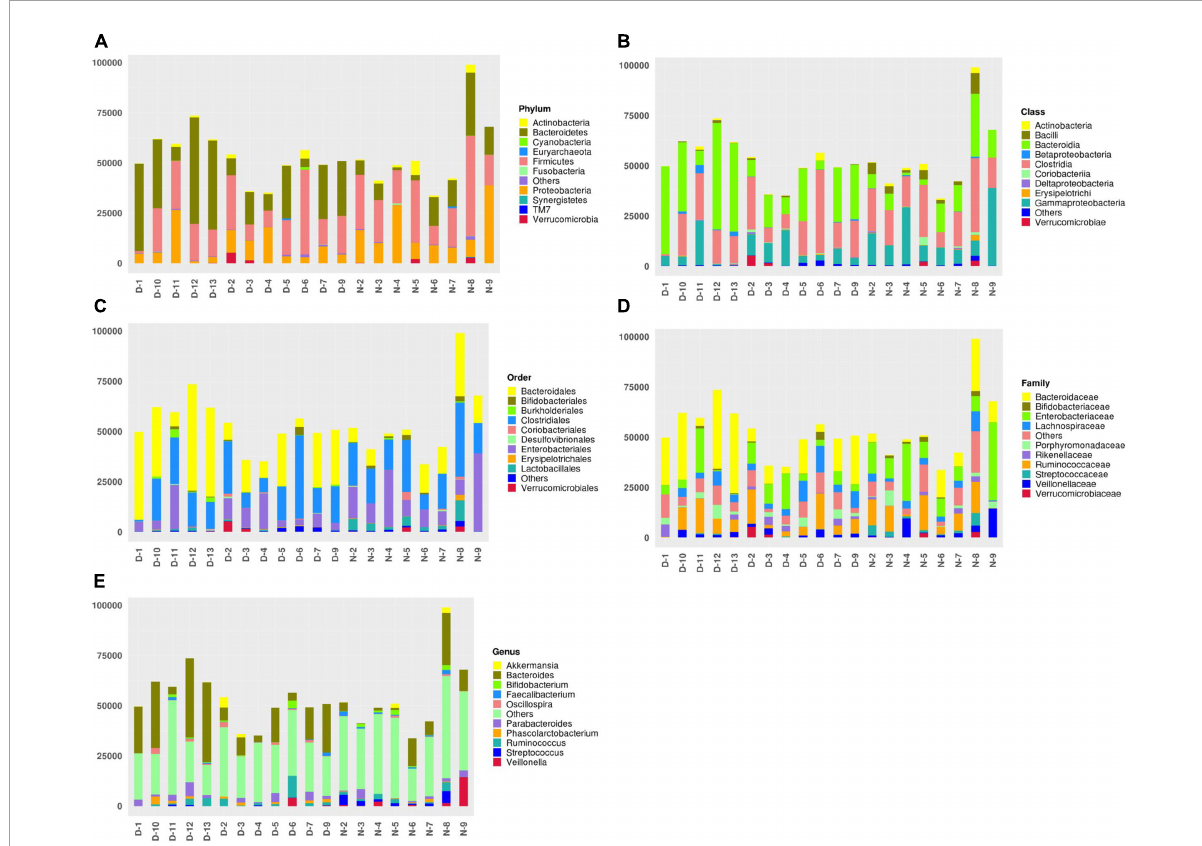
FIGURE1 (A) The top 10 bacteria at the phylum level: Actinobacteria, Bacteroidetes, Cyanobacteria, Euryarchaeota, Firmicutes, Fusobacteria, Others, Proteobacteria, Synergistetes, TM7, and Verrucomicrobia. (B) The top 10 bacteria at the class level: Actinobacteria, Bacilli, Bacteroidia, Betaproteobacteria, Clostridia, Coriobacteriia, Deltaproteobacteria, Erysipelotrichi, Gammaproteobacteria, Others, and Verrucomicrobiae. (C) The top 10 bacteria at order level: Bacteroidales, Bifidobacteriales, Burkholderiales, Clostridiales, Coriobacteriales, Desulfovibrionales, Enterobacteriales, Erysipelotrichales, Lactobacillales, Others, and Verrucomicrobiales. (D) The top 10 bacteria at the family level: Bacteroidaceae, Bifidobacteriaceae, Enterobacteriaceae, Lachnospiraceae, Others, Porphyromonadaceae, Rikenellaceae, Ruminococcaceae, Streptococcaceae, Veillonellaceae, and Verrucomicrobiaceae. (E) The top 10 bacteria at genus level: Akkermansia, Bacteroides, Bifidobacterium, Faecalibacterium, Oscillospira, Others, Parabacteroides, Phascolarctobacterium, Ruminococcus, Streptococcus, and